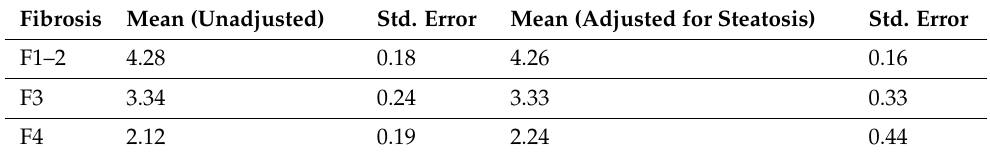
Table 6. Analysis of covariance for LCl_m2_dm2 by fibrosis with liver steatosis as the covariate. Fibrosis Mean (Unadjusted) Std. Error Std.